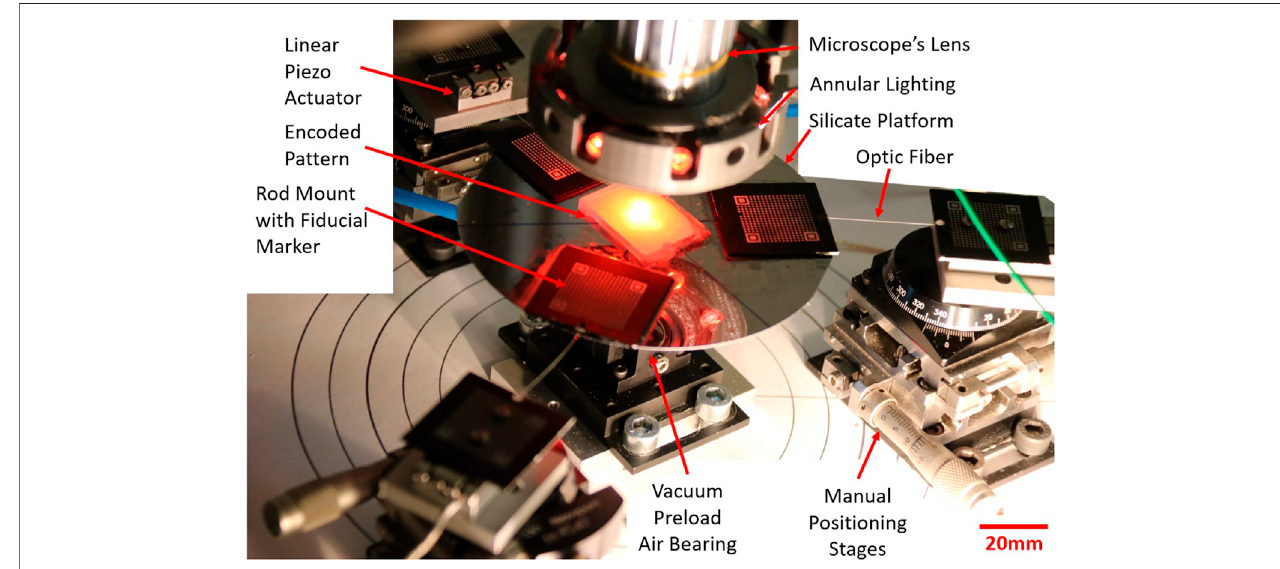
FIGURE 1 | Picture of the XY Θ parallel continuum robot.